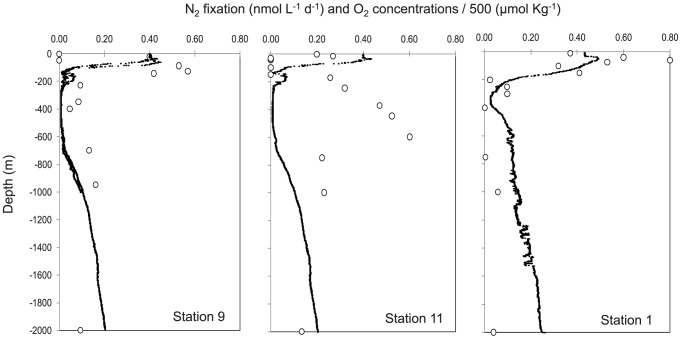
Vertical profiles (0–2000 m) of N2 fixation rates (nmol L−1 d−1) during the 2010 cruise (R/V Atlantis).Open circles: individual N2 fixation measurements at each depth. Black line: dissolved oxygen concentrations (µmol Kg−1) divided by 500 to fit on the same scale.